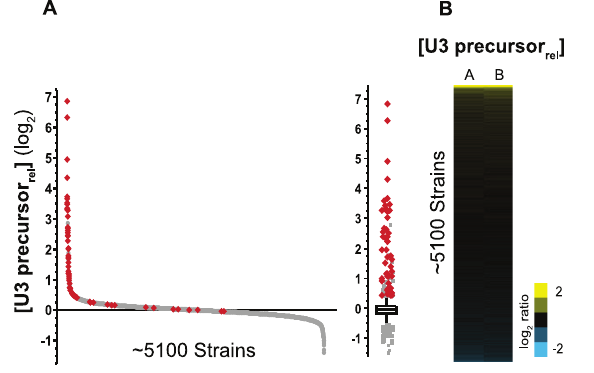
Figure 1. A subset of gene disruptions causes an increase in the unspliced levels of U3 snoRNA. A. The relative level of U3 snoRNA precursor in 5122 strains, ordered from the highest to lowest. Red data points highlight the strains containing mutations in a factor within the GO PROCESS: RNA Splicing category (see Figure S1). To the right, a box and outlier plot for the same dataset. B. False color representation of both the A (left) and B (right) biological replicates. The values are ordered from high to low, mirroring the data in